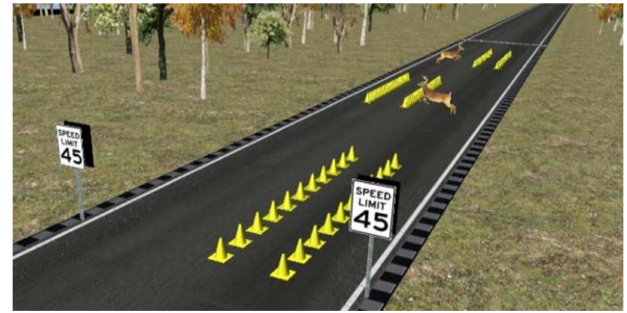
Figure 12. GBL Moose Test (isometric view).